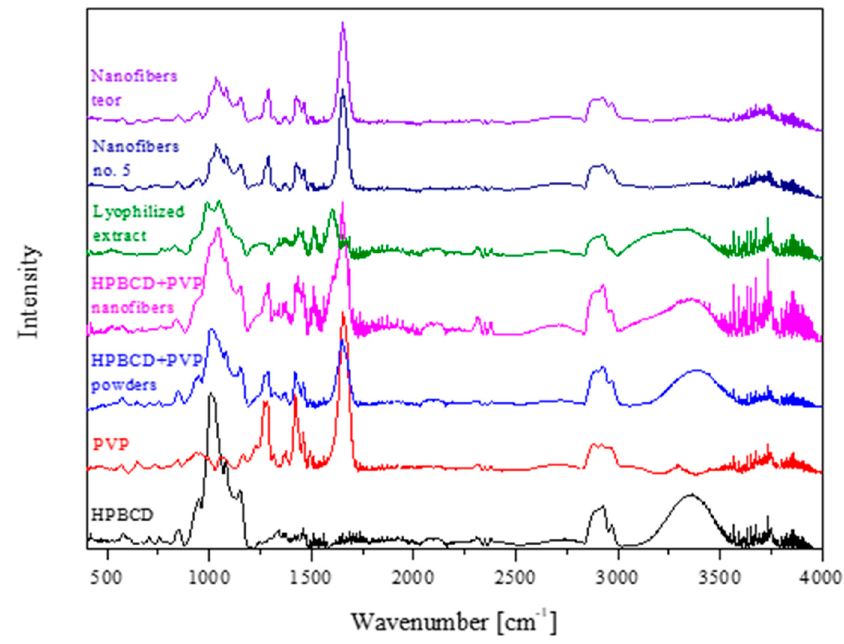
Figure 5. FTIR-ATR spectra for powder samples and nanofiber no. 5.